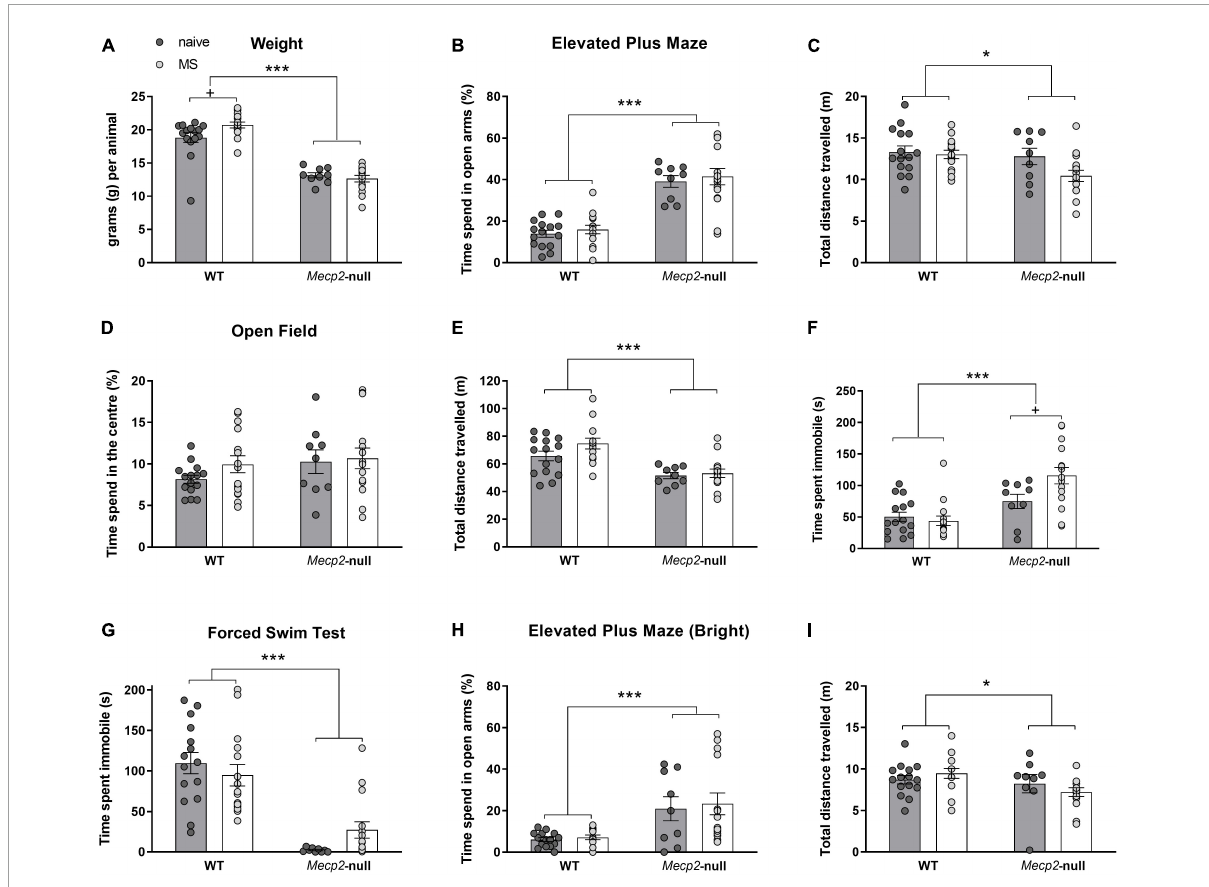
FIGURE2 Adolescent Mecp2 -null males show motor deficits and reduced anxiety- and depressive-like behavioural responses. Males from both genotypes, WT and Mecp2 -null, from either MS or naïve conditions were weighted and tested sequentially for EPM, OF and FST (WT-naïve, n = 15; WT-MS, n = 15, Mecp2 -null-naïve, n = 9; Mecp2 -null-MS, n = 15). (A) Body weight of the animals. In the EPM, (B) percentage of time in the open arms of the maze, and (C) distance travelled. In the OF, (D) percentage of time spent in the centre of the arena, and (E) total distance travelled. Time spent immobile (F) . In the FST, (G) mutant mice spend significantly less time immobile than their WT counterparts. One week after previous behavioural assays, WT and Mecp2 -null male mice, from either MS or naïve conditions were re-exposed to EPM under bright light conditions. (H) Time in the open arms of the maze and (I) Distance travelled. Graph show individual values and mean ± standard error mean (SEM) for each group. * p < 0.05, *** p < 0.001 by genotype; + p < 0.05 by group. EPM, elevated plus maze; FST, forced swimming test; MS, maternal separation; OF, open field; WT,